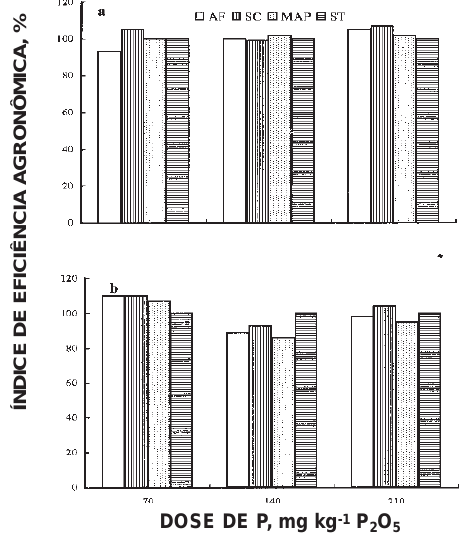
Figura 4. Índices de eficiência agronômica relativos aos dados de absorção de fósforo obtidos nos latossolos vermelho-amarelos, unidades Itororó (a) e Três Barras (b) (AF: ácido fosfórico; SC: suspensão coloidal 10-30-00; MAP: fosfato monoamônico, e ST: superfosfato triplo).